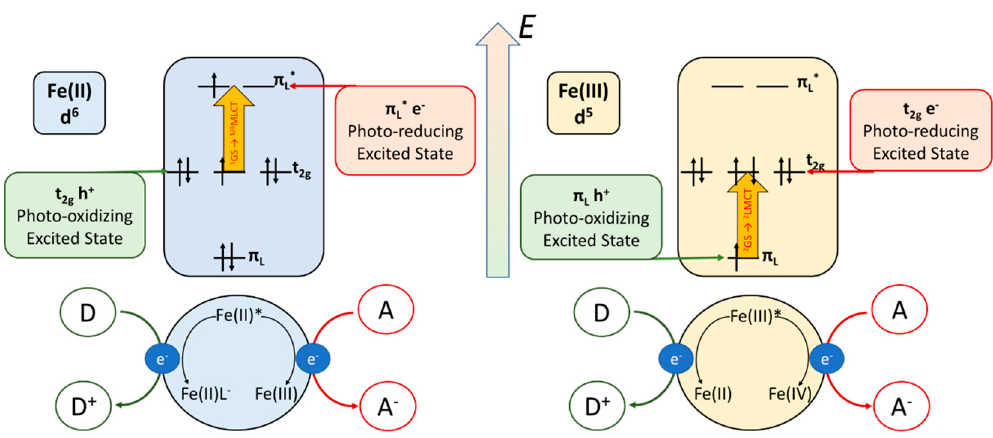
Figure 15. Fundamental photoredox processes for Fe(II)/d 6 (left) and Fe(III)/d 5 (right) systems. Note that the different excitation processes involve different ligand orbitals that contribute to making the Fe(II)/MLCT and Fe(III)/LMCT cases fundamentally different in terms of excited state oxidation and reduction capabilities.